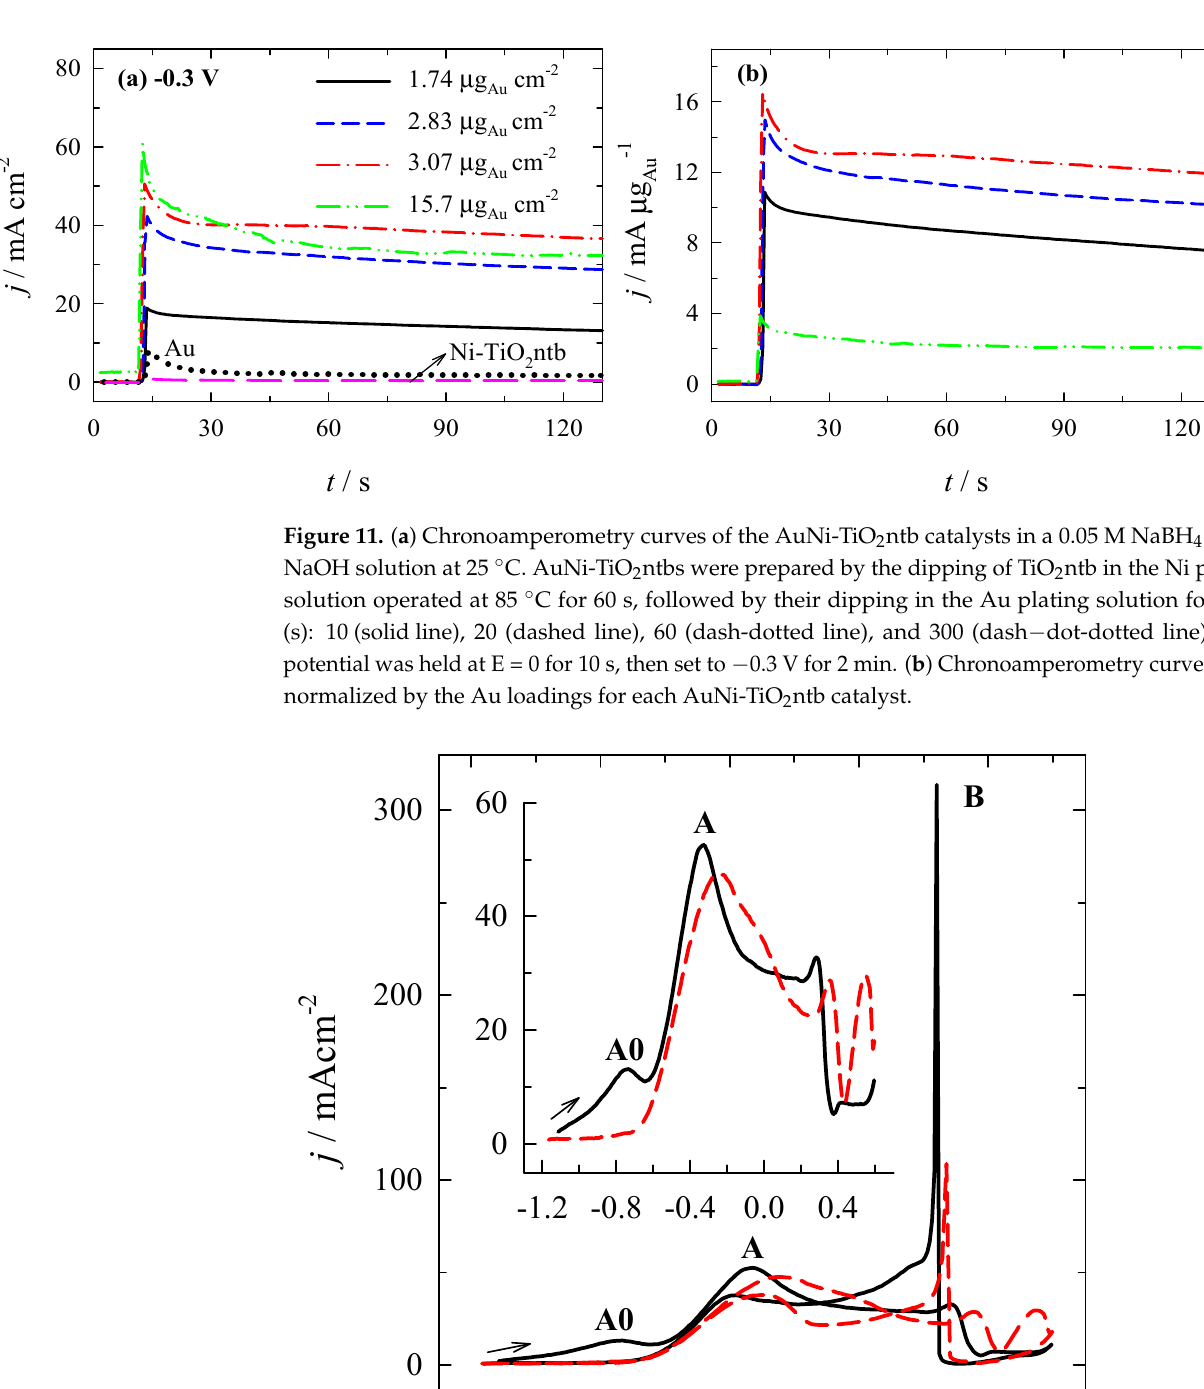
Figure 11. ( a ) Chronoamperometry curves of the AuNi-TiO 2 ntb catalysts in a 0.05 M NaBH 4 + 1 M